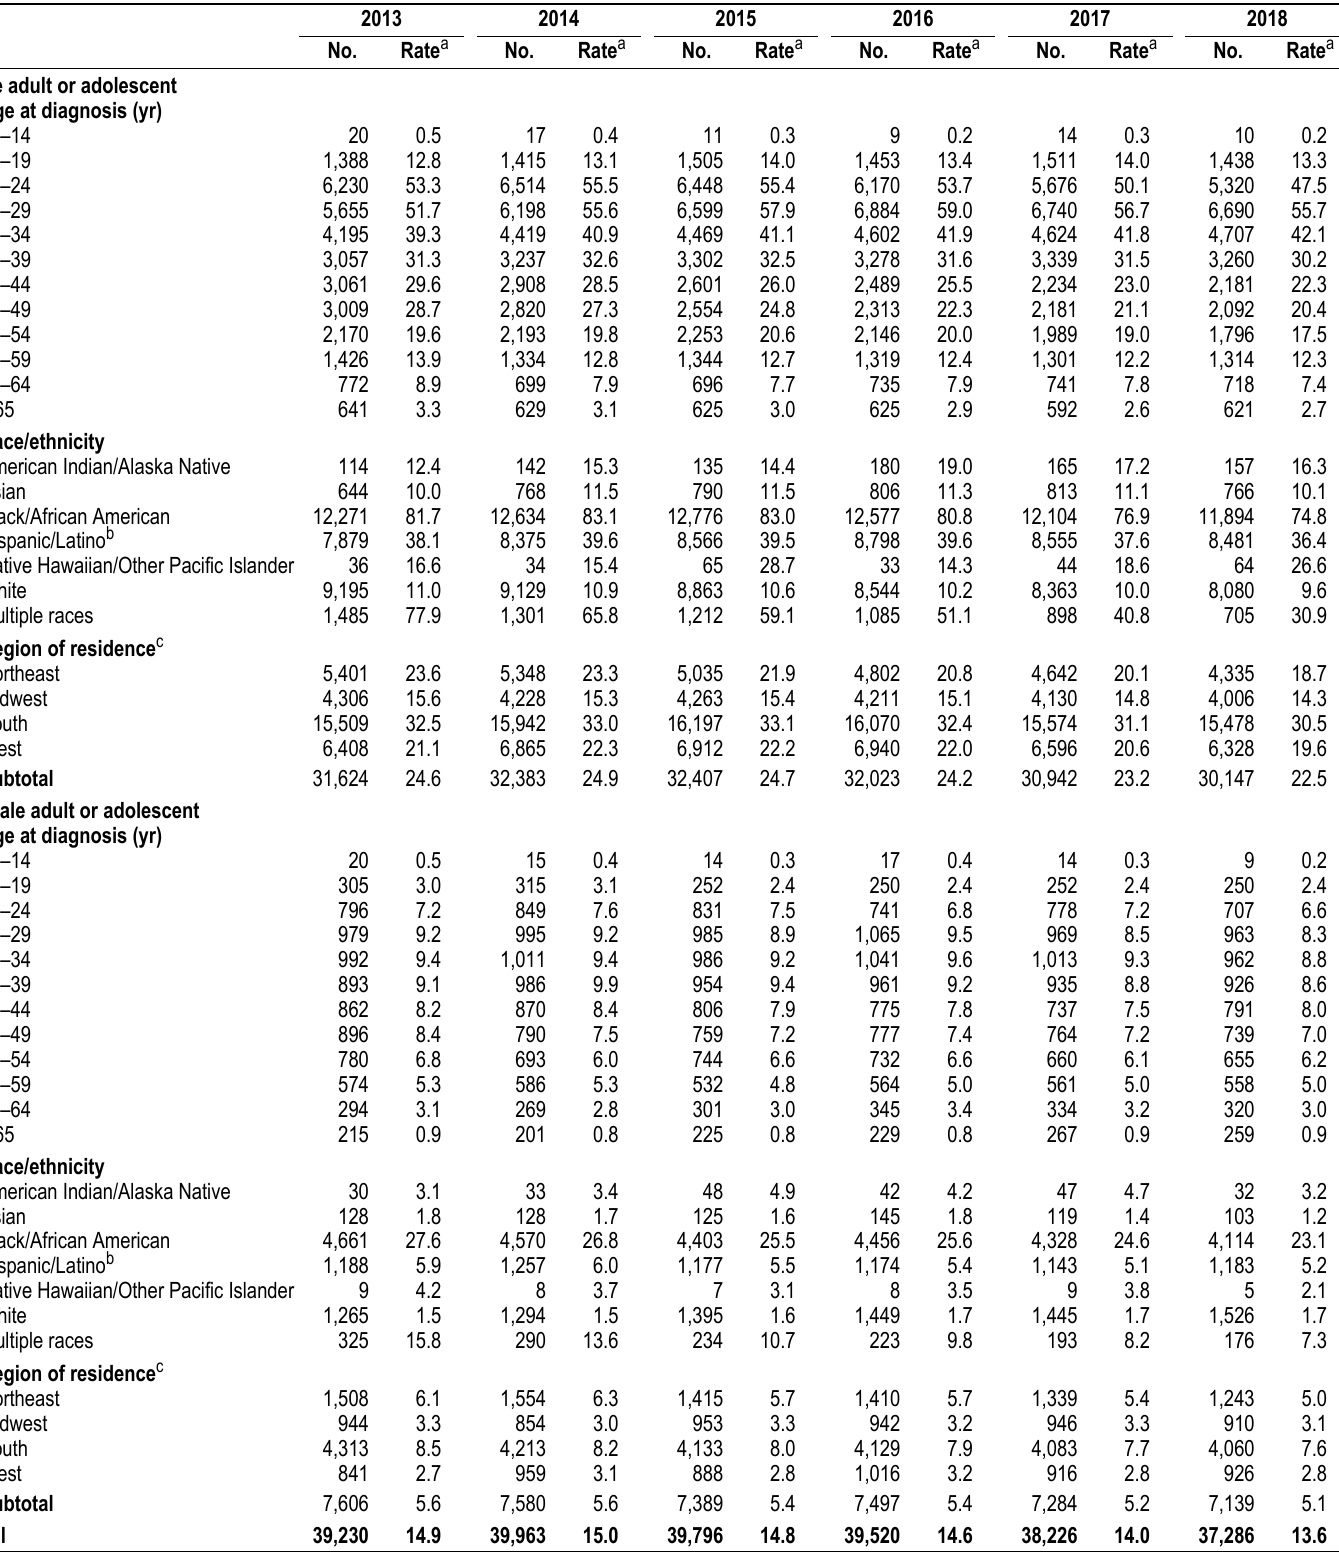
Table 5a. Diagnoses of HIV infection among adults and adolescents, by year of diagnosis, sex, and selected characteristics, 2013–2018— United